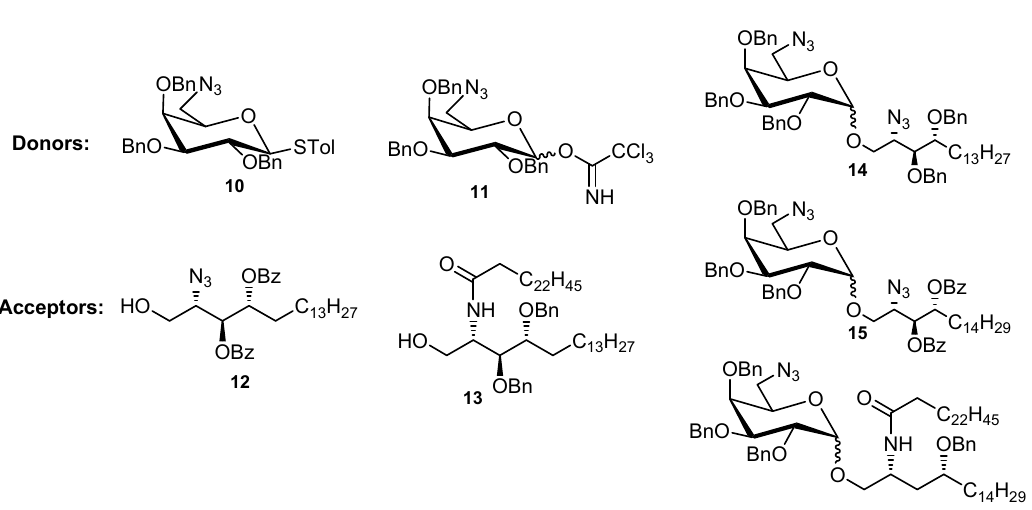
Figure 1. Donors and acceptors used for preparing glycosylated products.